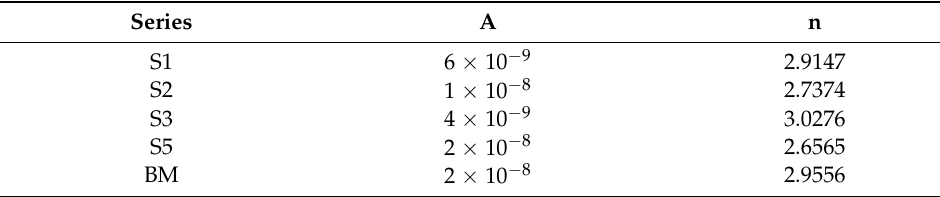
Figure 8. Fatigue crack growth rate at Paris regime. ( a ) da/dN- ∆K and ( b ) da/dN- ∆K eff . Table 4. A, n parameters of the FCGR 1 curves as a function of ∆K eff .